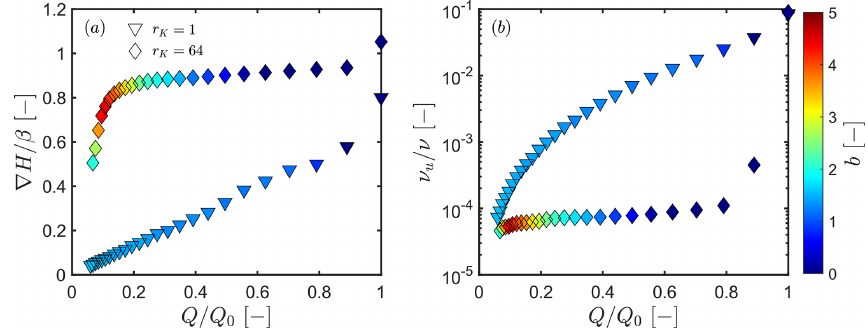
Figure C1. (a) The progression of the average head gradient ∇ H , normalized by the slope of the interface β . (b) The change in saturation area of the upper compartment ν u with respect to the total saturation area ν , as a function of Q/Q 0 . Triangular symbols are for the case where r K = 1, while diamond ones are for r K = 64. The colours of the symbols show the magnitude of b during recession.